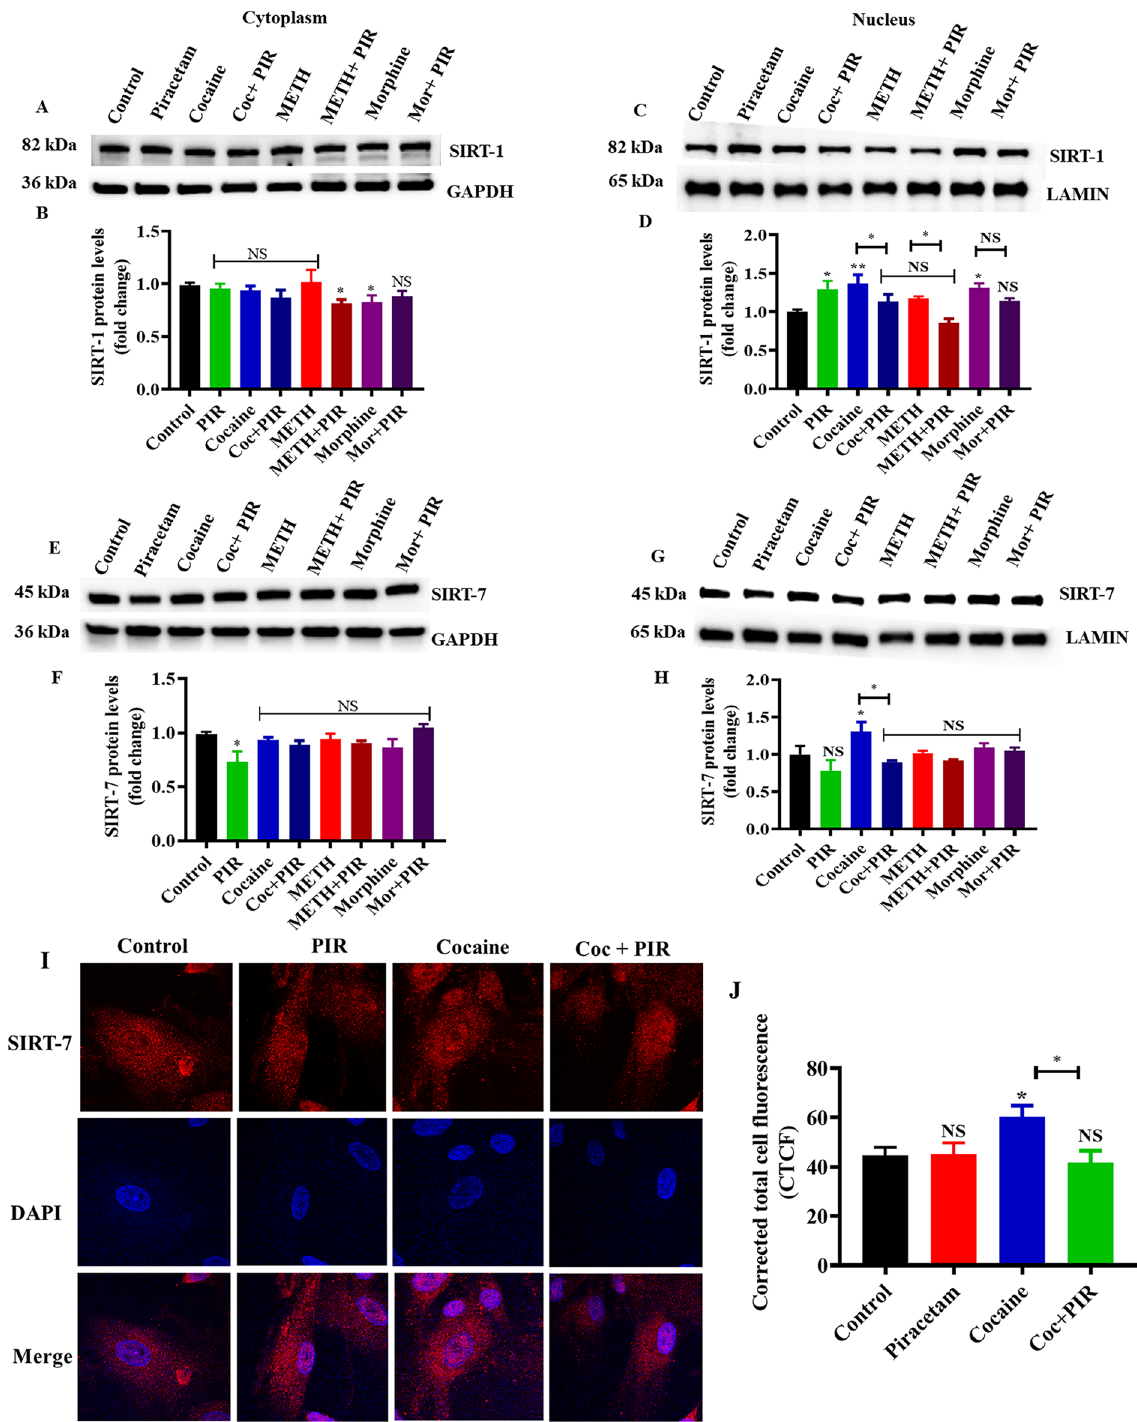
Figure 7. The protective effects of piracetam against the impact of psychostimulants and opioids on the cytoplasm and nuclear SIRT-1 and SIRT-7 protein expression. Human primary astrocytes were exposed to cocaine (1 µM), METH (10 µM) and morphine (5 µM) alone or in combination with piracetam (10 µM) for 24 h to isolate the nuclear fraction. Controls were maintained in drug-free medium (without drug exposure). Representative blots showing the expression of cytofractions ( A ) SIRT-1 and ( E ) SIRT-7 and nuclear fractions ( C ) SIRT-1 and ( G ) SIRT-7. ( B , D , F , H ) Densitometric analyses of each protein level to its corresponding loading control GAPDH and LAMIN (fold-change from control). ( I ) Effects of the psychostimulant cocaine on the expression and translocation of SIRT-7. SIRT-7 expression (red) and nuclear staining with DAPI (blue) were observed using confocal microscopy (magnification 100x, scale bar 100 μm). ( J ) Quantification of SIRT-7 fluorescence intensity (CTCF). Data are expressed as the means ± SD of three independent experiments. **P < 0.01, *P < 0.05, NS—Nonsignificant. Coexposure of psychostimulant or opioid with piracetam compared to psychostimulant or opioid alone. The supplementary information includes all full-length